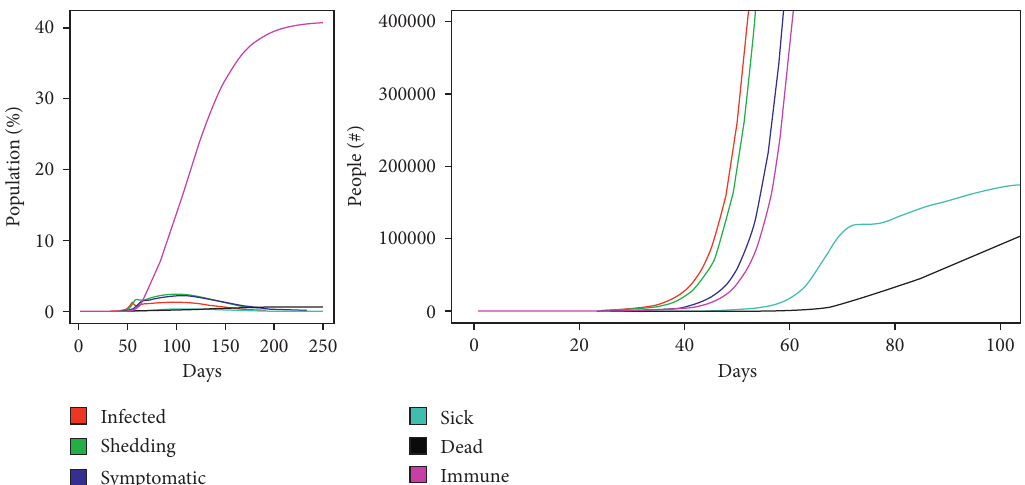
Figure 9: Model simulations implementing social distancing with R